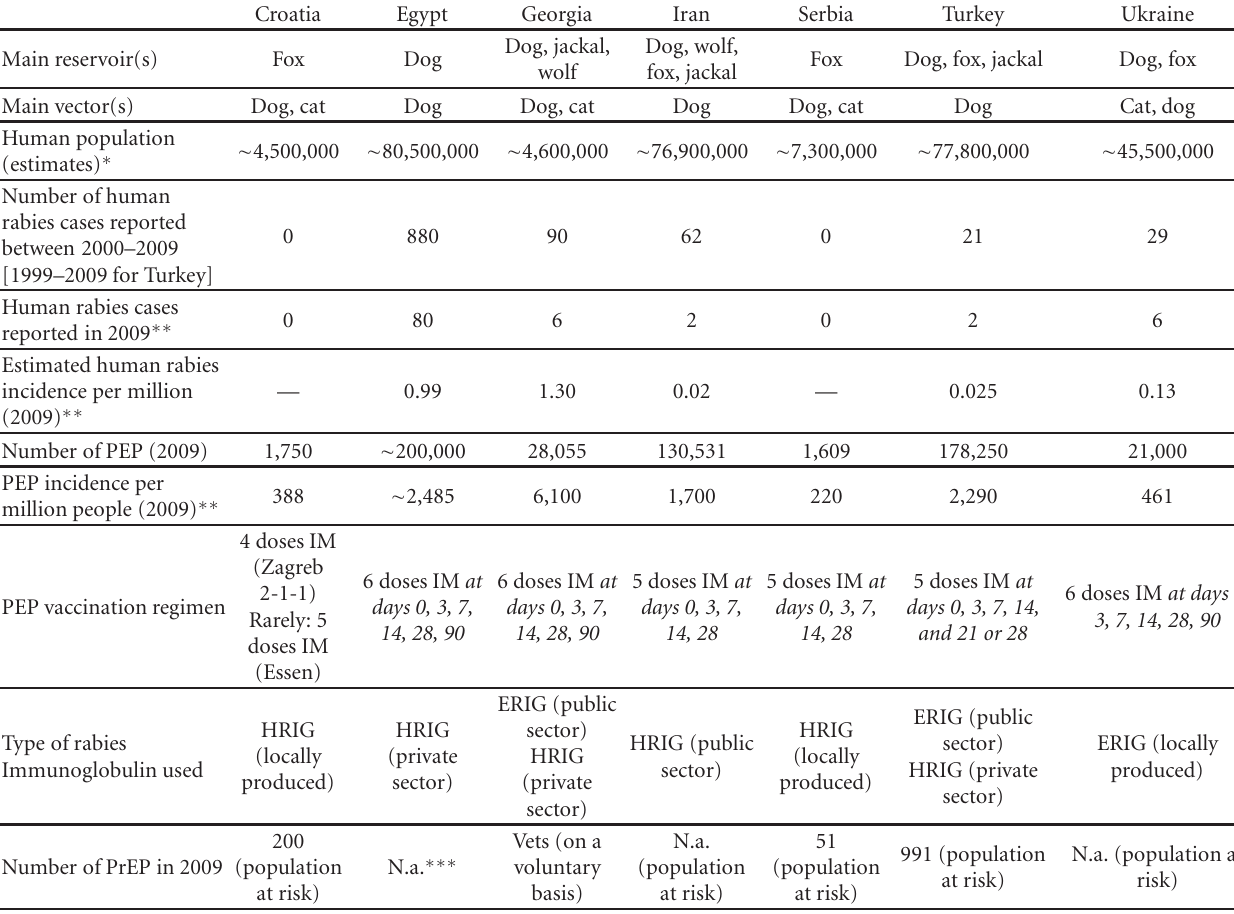
Table 1: Rabies epidemiology and management in the 7 countries represented at